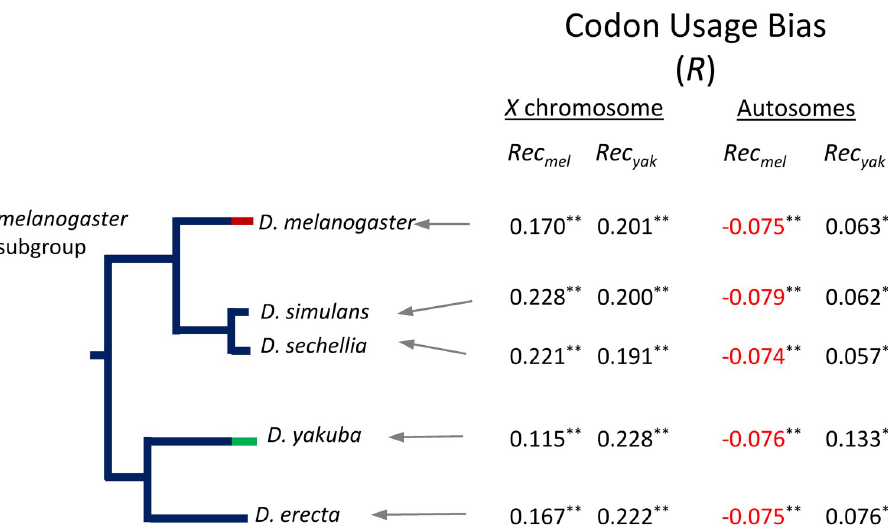
Fig 7. Correlation between codon usage bias (CUB) and crossover rates in D . yakuba ( Rec ( Rec mel ). A generalized linear model (GLM) was used to estimate the correlation coefficient R between crossover rates